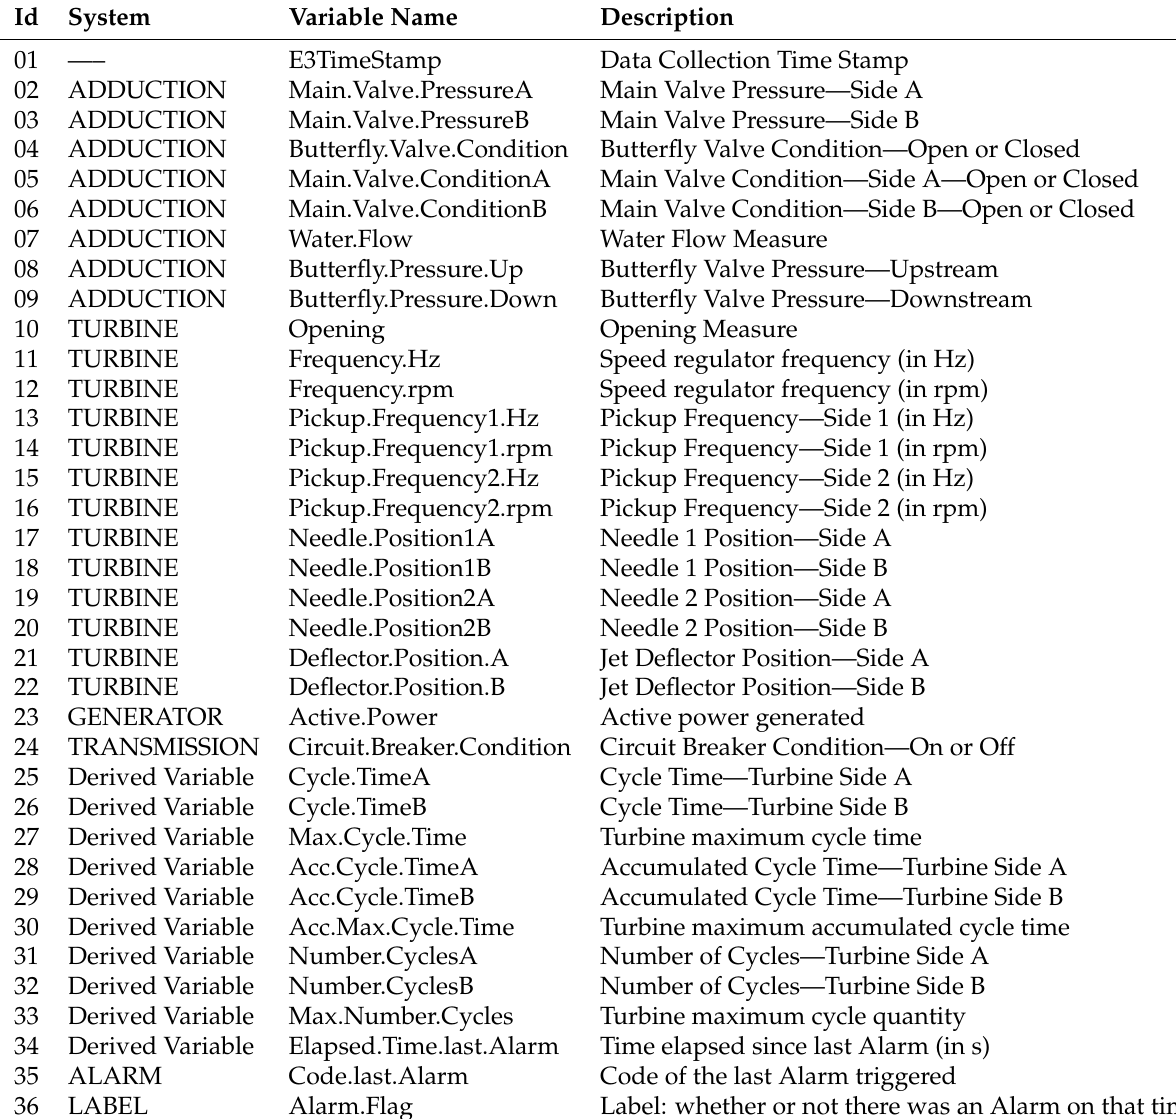
Table 1. Load Cycle: Critical Variables.